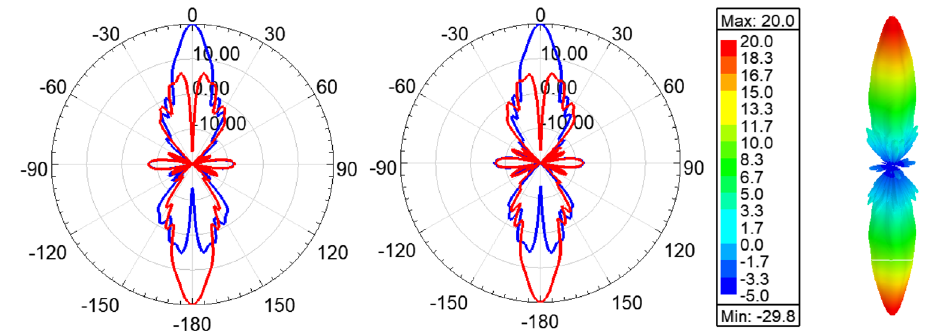
Figure 17. Radiation pattern at 20 GHz in xz -plane (left), yz -plane (middle), and 3D pattern (right), LHCP Co-polar (blue), and RHCP Cross-polar (red).